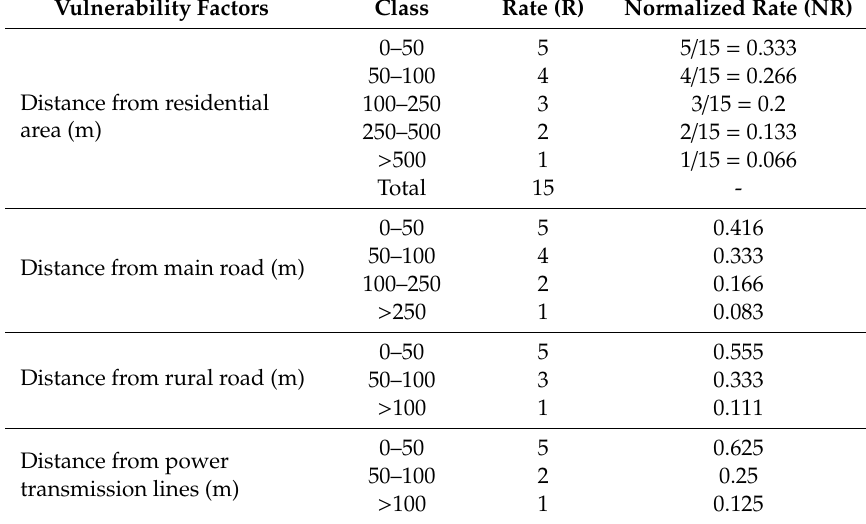
Table 4. Normalized rates (NR) for classes of the vulnerability factors.